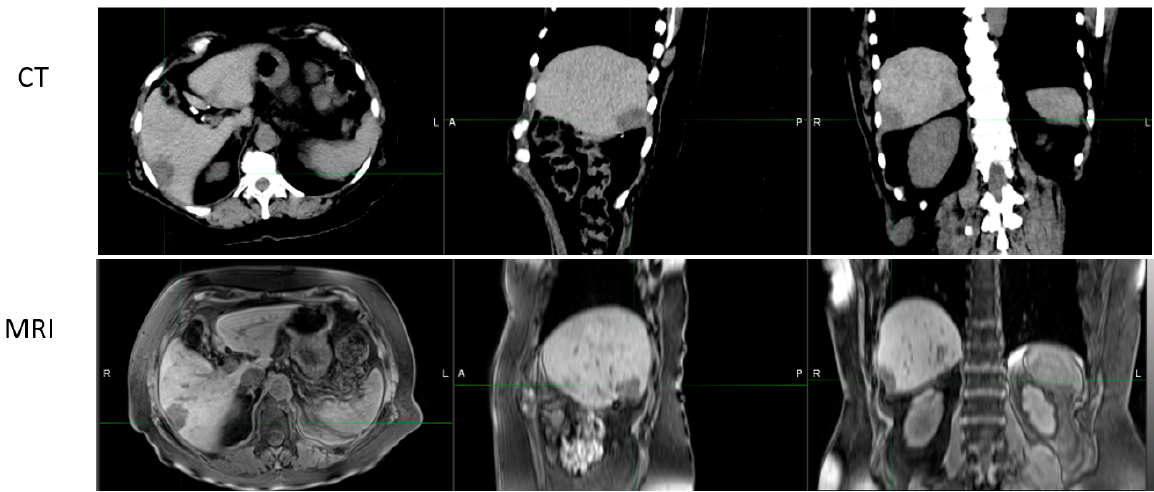
Figure 1. Axial, sagittal coronal images of abdomen region. Upper panel, CT data; lower panel, MRI image. Please note that soft tissue structures are more discernible in MRI than CT images.